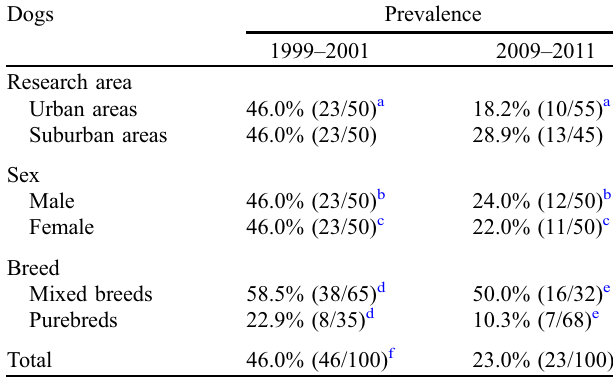
Table 1. Seroprevalence of Dirofilaria immitis infection in shelter